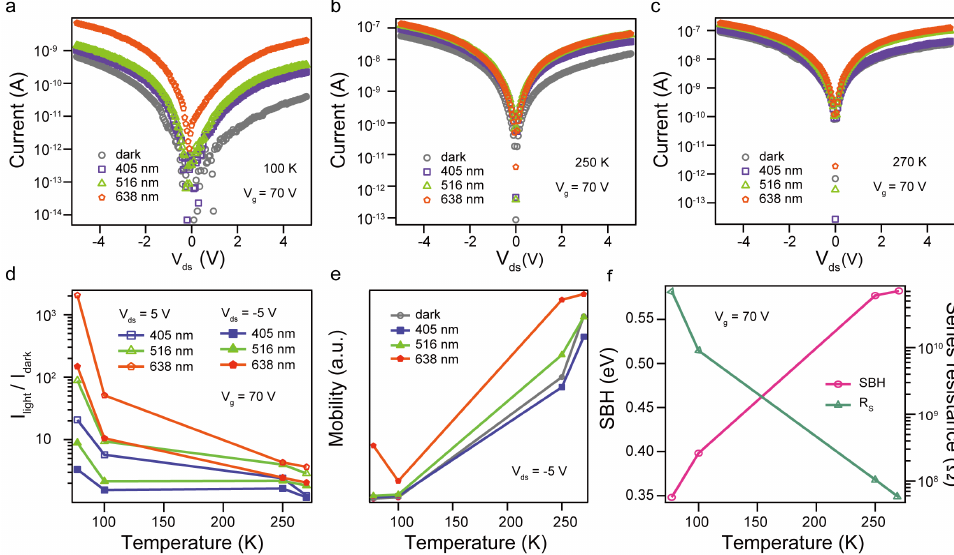
Figure 4. Temperature-dependent photoresponse of the NiPS 3 photodetector. ( a – c ) The current- voltage curves of the NiPS 3 device at 100, 250, and 270 K, respectively. ( d ) Photoresponsivity as a function of temperature under different light illumination (405, 516, and 638 nm). V ds = − 5 V and V g = 70 V. ( e ) The carrier mobility for temperature ranging from 77.3 to 270 K, at external bias of − 5 V. ( f ) Temperature dependent Schottky barrier height (SBH) (rose red) and series resistance (R (green) at gate voltage of 70 V, in the